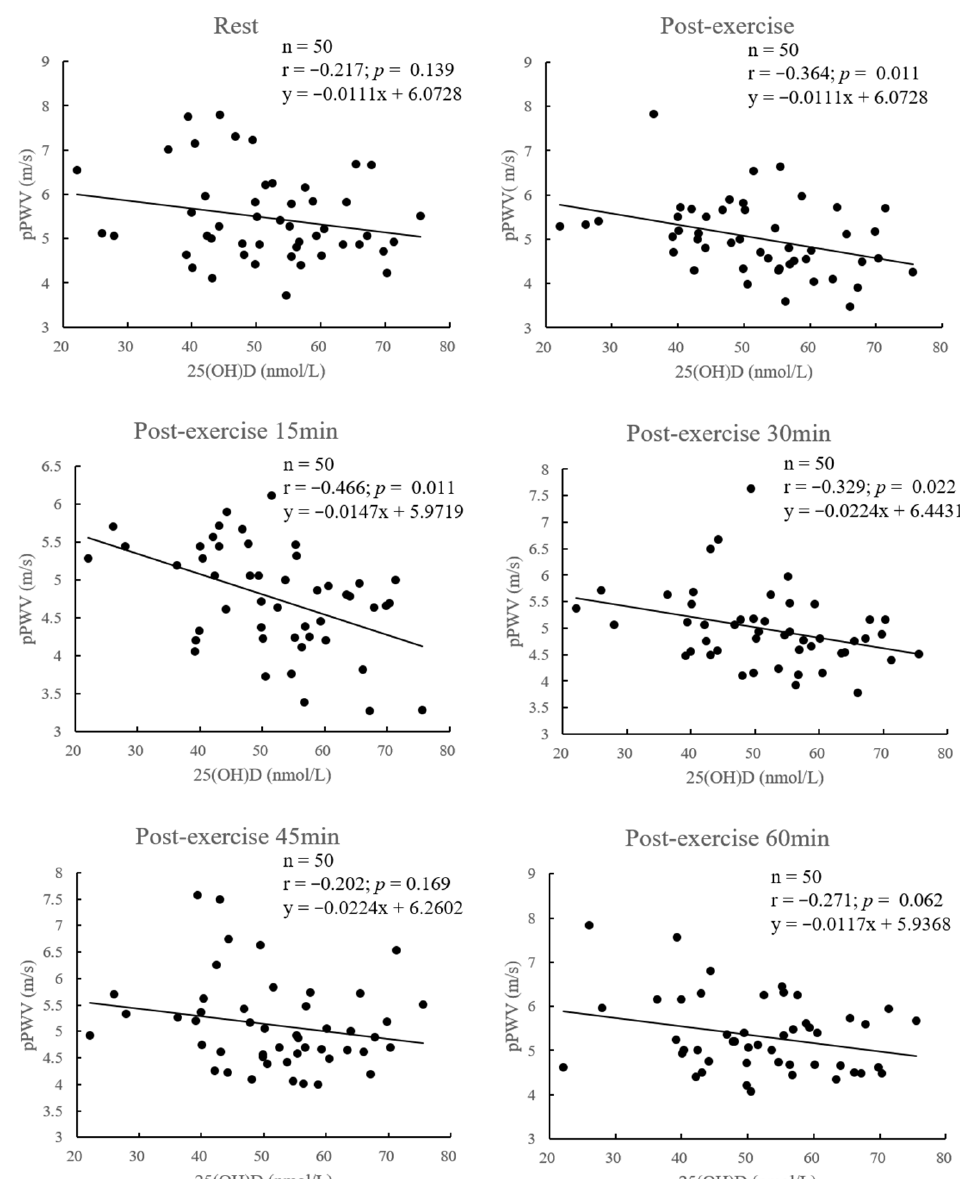
Figure 2. Relationship between vitamin D status and pPWV following exercise at rest and 0, 15, 30, 45, 60 min. Abbreviations: pPWV, peripheral pulse wave velocity.